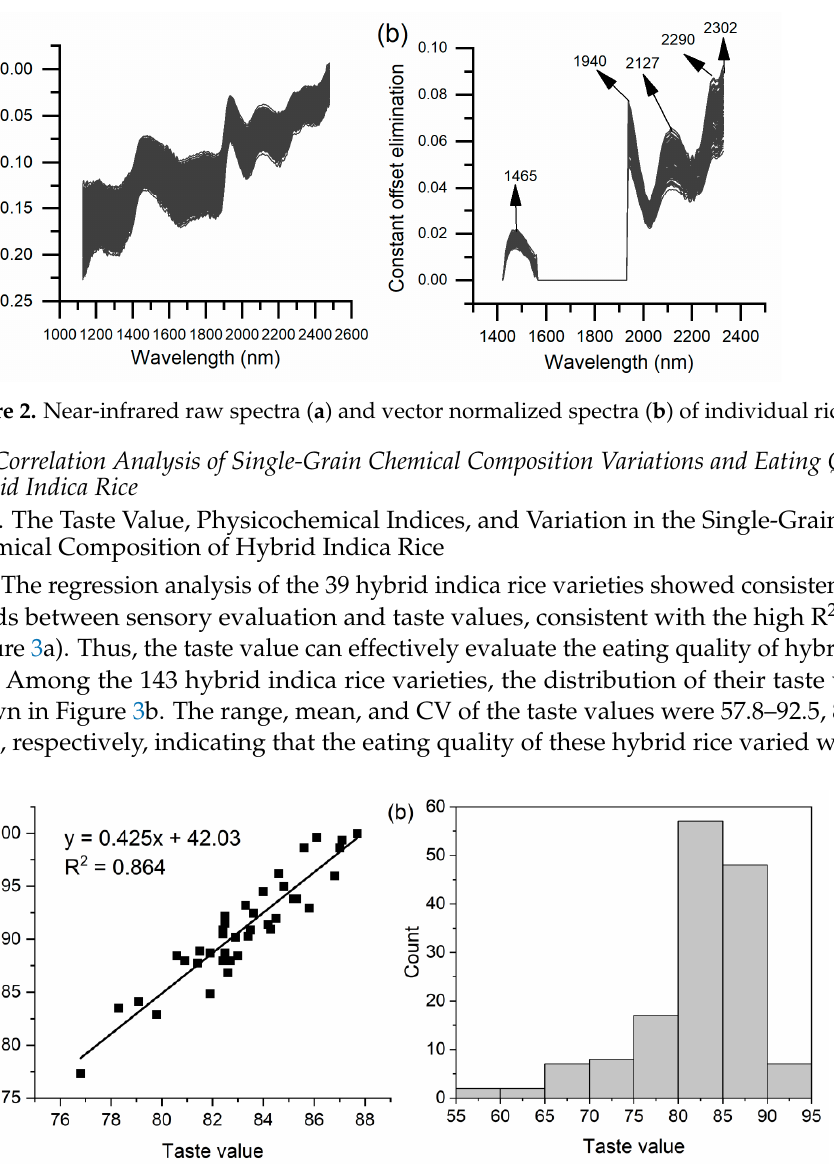
Figure 3. The regression analysis between taste values and sensory scores ( a ), and the distribution of taste value of 143 hybrid indica rice ( b ).